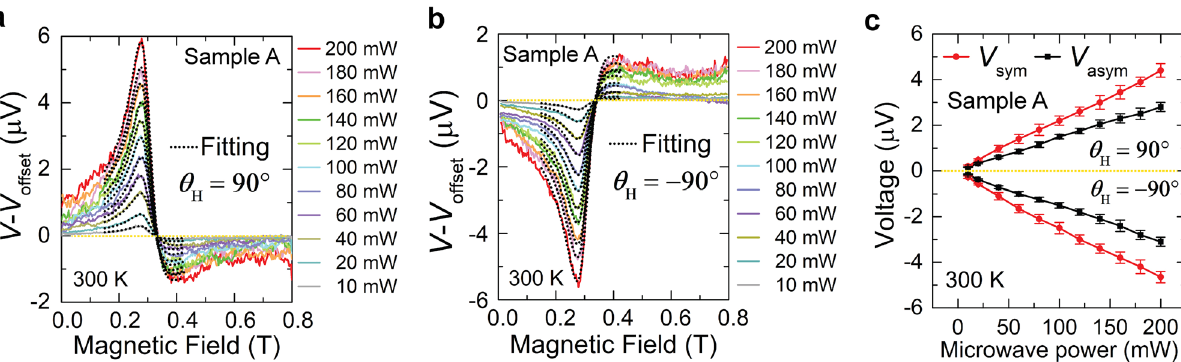
Figure 2. ( a ) and ( b ) Magnetic field μ 0 H dependences of the voltage signal V (offset voltage V offset is subtracted) in the BiSb/(Ga,Fe)Sb heterostructure (sample A) measured at 300 K at various microwave powers, ranging from 10 to 200 mW, for θ H = 90° and –90°, respectively. The black dotted curves represent fitting which includes a summation of the symmetric and antisymmetric voltage components. ( c ) Microwave power dependence of the symmetric voltage component magnitude V sym and antisymmetric voltage component magnitude V asym at θ H = 90° and –90°. The errors bars in ( c ) are standard deviations obtained from the fitting of the EMF peaks.